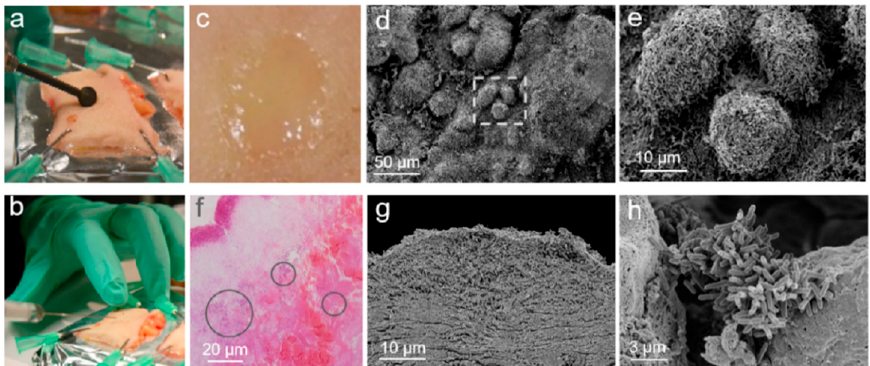
Figure 4. Wound infection model with the P. aeruginosa strain PAO1. ( a ) A superficial wound of approximately 5 mm in diameter was produced on skin explants. ( b ) Bacteria (1 × 10 7 per wound) were inoculated and skin explants, which were incubated for 20 h in the previous analysis. ( c ) Microscopic appearance of a representative wound 20 h after the PAO1 injection. ( d , e ) SEM images of the wound surface at two different magnifications showing the typical morphology of bacterial communities in the biofilm. ( f ) Wound section stained with H&E showing a bacteria layer on the surface of the wound and bacteria agglomerates deep into the tissue (circles). ( g , h ) SEM images of wound sections at different magnifications confirming bacterial growth on the surface ( g ) and deep in the wound tissue ( h ).